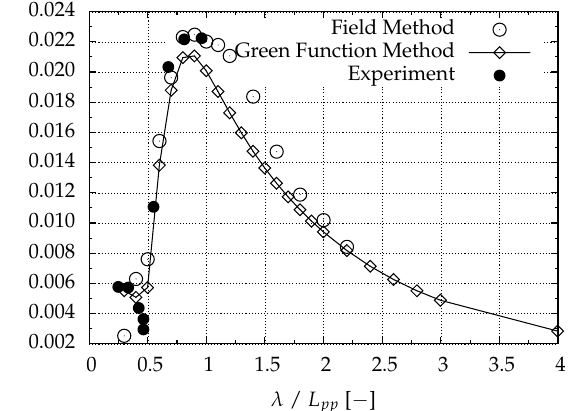
Figure 6. Containership: midship vertical bending moment M y . ρ is the water density, g the gravity constant, B the ship’s breadth and L pp the ship